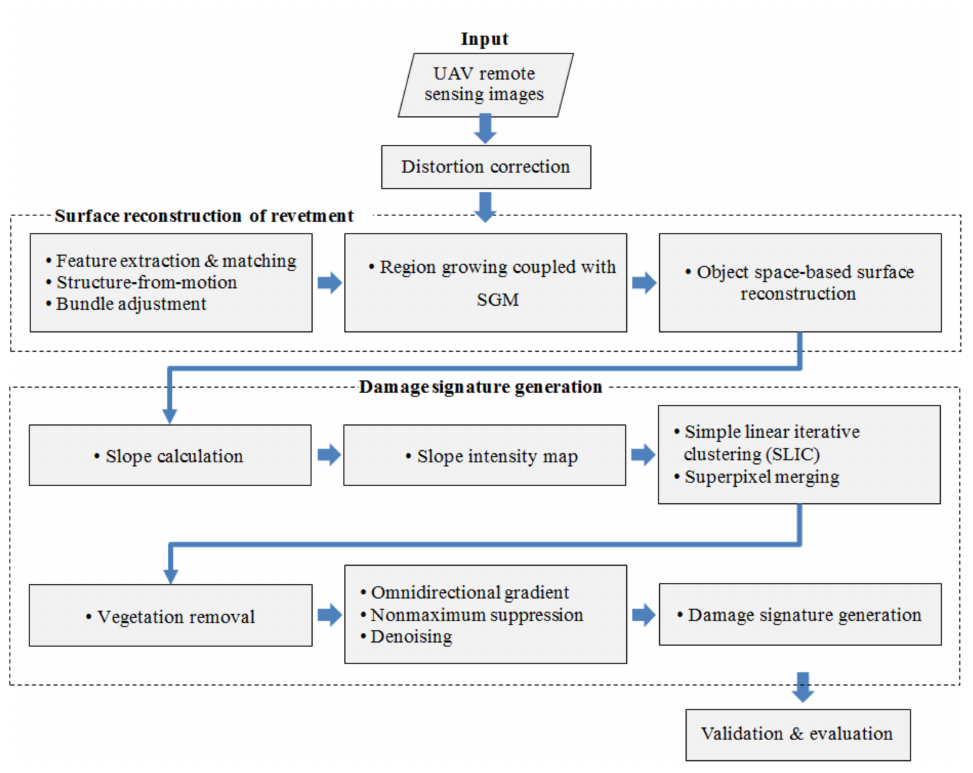
Figure 3. Workflow of the revetment damage recognition along urban rivers through dense point clouds derived from low-cost UAV